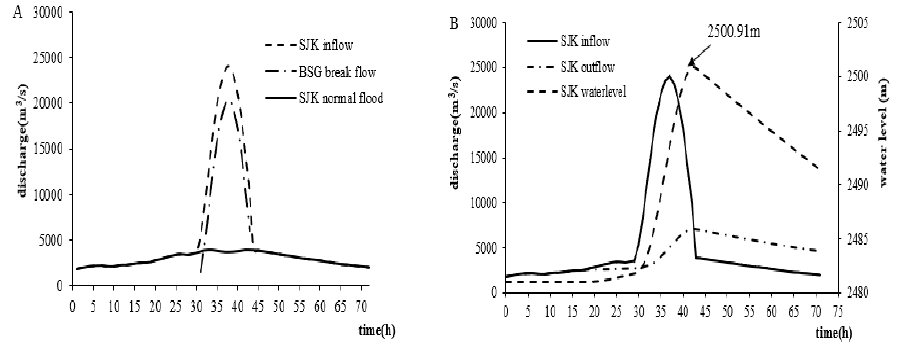
Figure 15. ( A ) The BSG break flood encounters SJK normal flood; ( B ) the regulated flood progress of SJK.